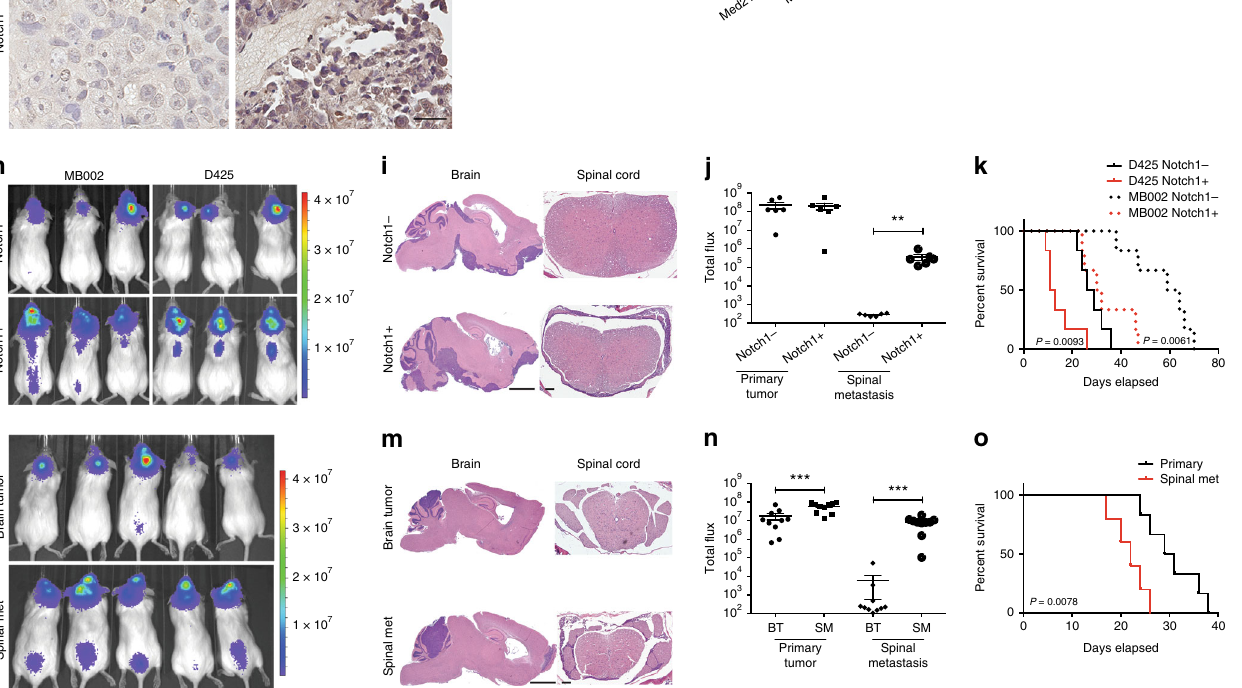
xenografts (Fig. 1b) and separately transplanted them into mouse medulloblastoma cells from primary mouse tumors in the cerebella (low frequency of NOTCH1 + cells) and from spinal